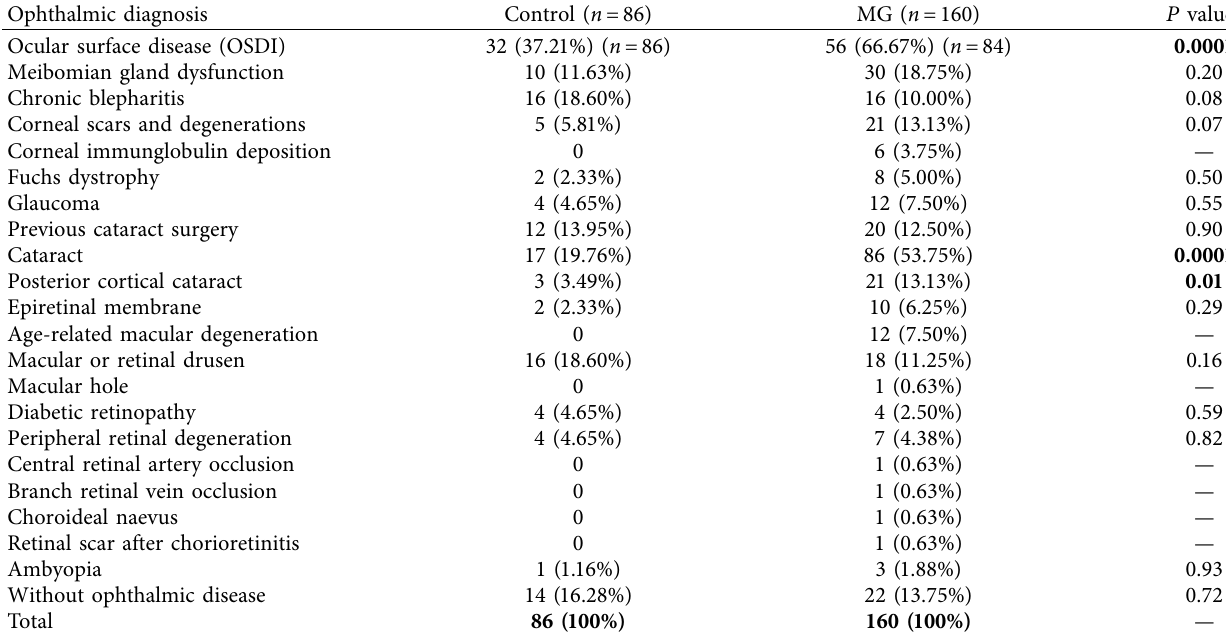
Table 3: Ophthalmological findings in control subjects (86 eyes) and in patients with monoclonal gammopathy (MG) (160 eyes, except for ocular surface disease, as OSDI questionnaire has only been filled through 42